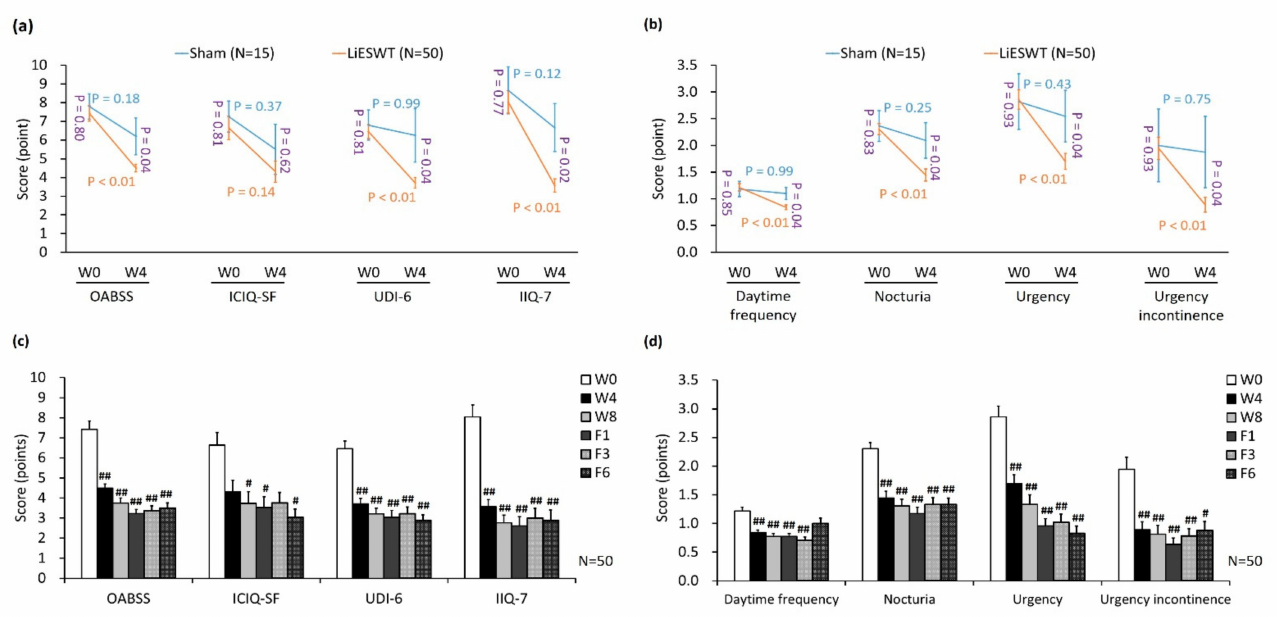
Figure 3. Improvement of OAB symptoms and life bothersome questionnaire scores after LiESWT treatment. ( a , c ) The therapeutic effect of LiESWT was analyzed by the OAB symptoms and life bothersome questionnaires, including OABSS, ICIQ-SF, UDI-6, and IIQ-7. LiESWT treatment significantly reduced the scores of OABSS, ICIQ-SF, UDI-6, and IIQ-7 as compared with the sham group. ( b , d ) Improvement of questionnaires scores for OAB symptom after LiESWT treatment, including daytime frequency, nocturia, urgency, and urgency incontinence. LiESWT improved OAB symptoms and the QoL. OABSS, overactive bladder symptom scores. ICIQ-SF: international consultation on incontinence questionnaire-short form, UDI-6: urogenital distress inventory–6, IIQ-7: incontinence impact questionnaire-7, W0: the baseline, W4: 4-week LiESWT treatment, W8: 8-week LiESWT treatment, F1: 1-month follow-up, F3: 3-month follow-up. The blue or orange font denotes the p -value before and after 4 weeks treatment in the sham group or in the LiESWT group, respectively. The purple font indicates the p -value between the sham group and the LiESWT group at the W0 and W4. # p < 0.05; ## p < 0.01 compared to